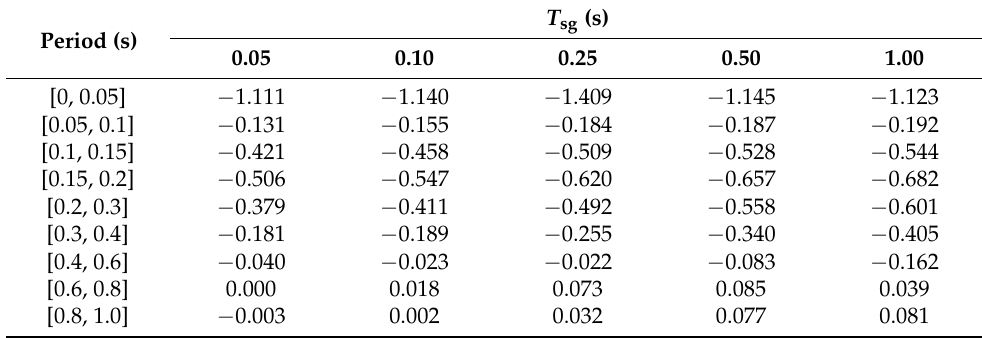
Table A8. RoCoF ( T sg was